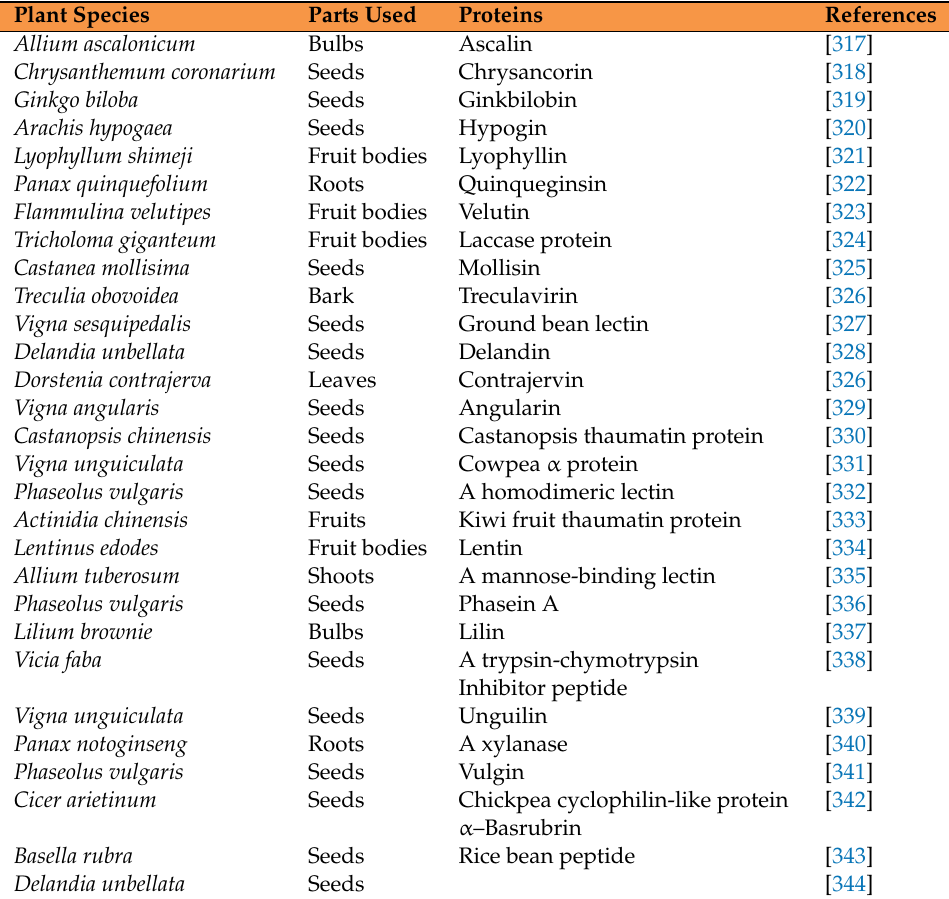
Table 4. Proteins containing plants used in